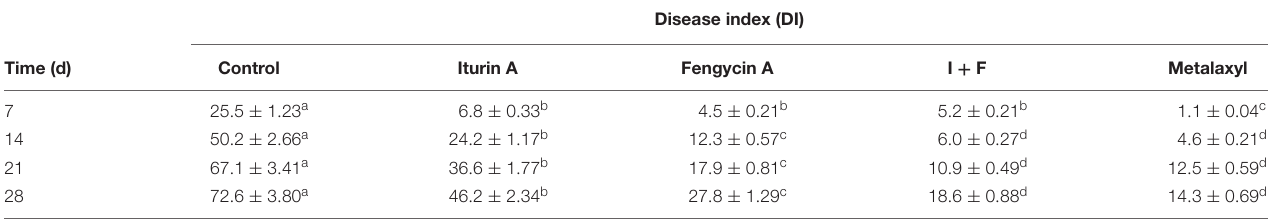
TABLE 4 | Disease index after Iturin A and Fengycin A protection in greenhouse experiments.